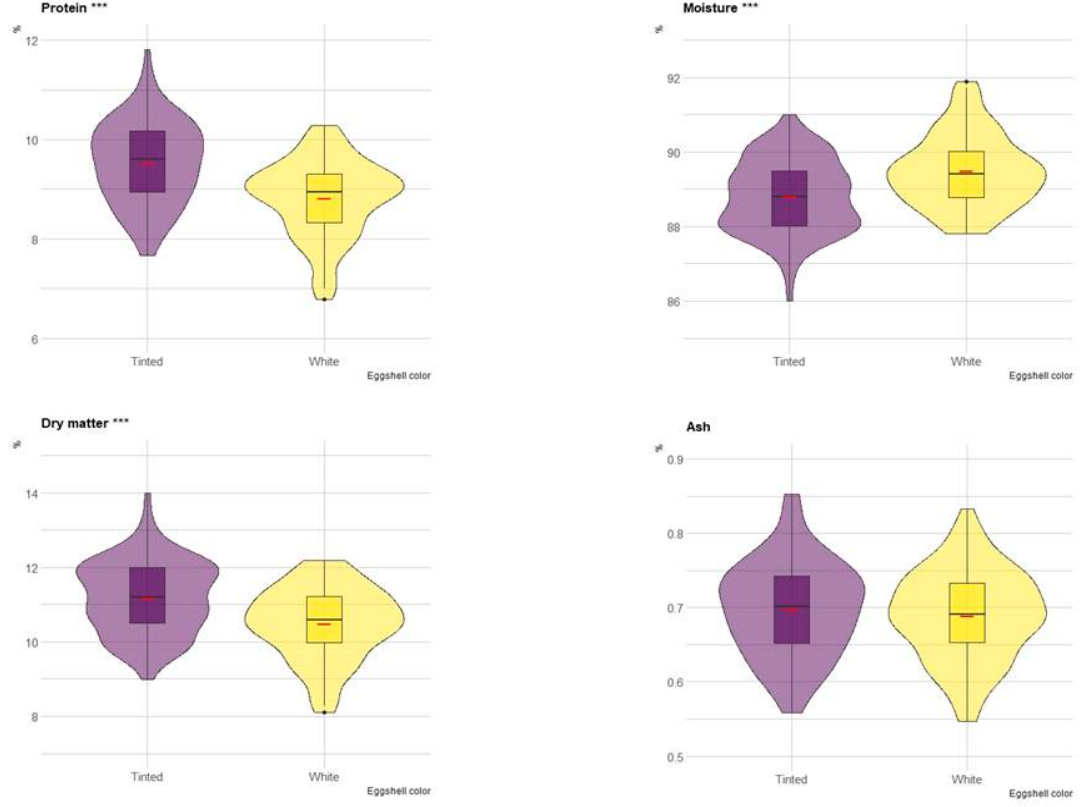
Figure 2. Boxplot of the composition (on a wet basis) of albumen in eggs of tinted (violet) and white (yellow) shell. Red dash indicates mean value. The violin blot represents the data distribution. *** p < 0.001.